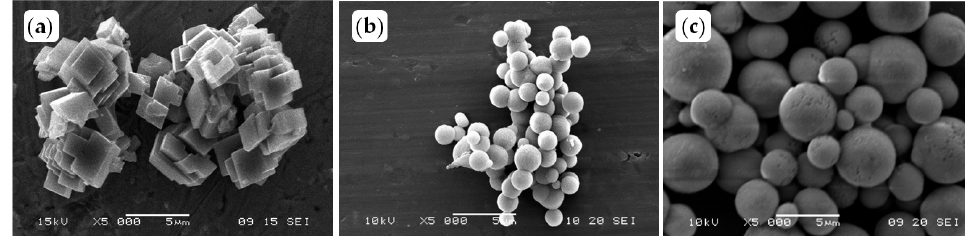
Figure 7. SEM micrographs of CaCO 3 ‘hollow closed’ microspherical particles obtained in the presence of a triblock copolymer PEG750- b -[(P(O)(H)O(CH 2 ) 6 ] 17 - b -PEG750 for concentration of modifier 3 g · L − 1 . Reprinted with permission from [53]. Copyright (2005) Wiley-VCH Verlag GmbH & Co.